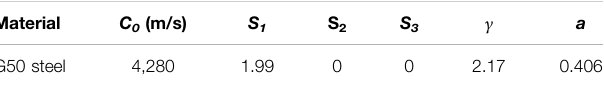
TABLE 4 | Parameters of EOS for G50 steel